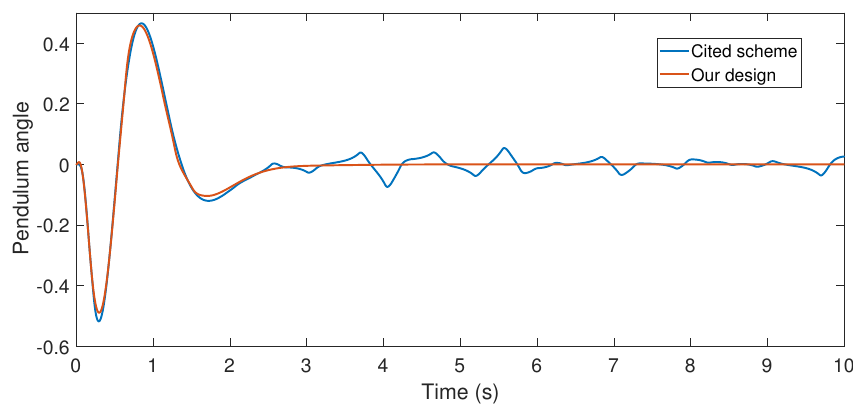
Figure 4. Numerical experiment results: pendulum angle